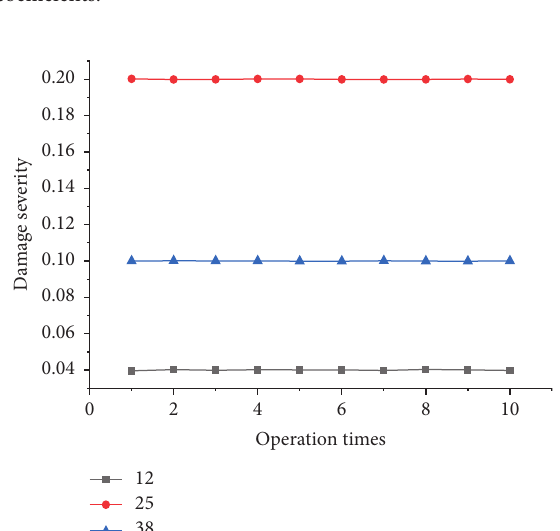
Figure 4: Damage severity identification of 0.8PSO.